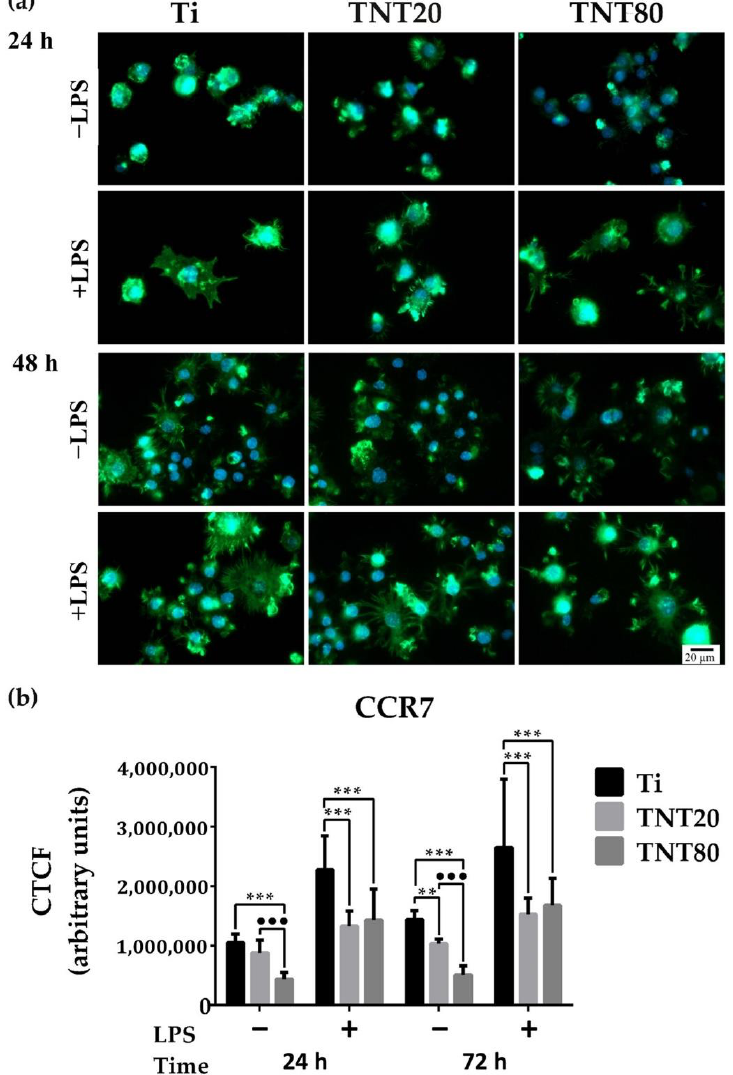
Figure 4. CCR7 expression in RAW 264.7 cells maintained in contact with the Ti, TNT20, and TNT80 surfaces for 24 h and 48 h, both under standard (−LPS) and pro-inflammatory (+LPS) culture condi- tions. ( a ) Immunofluorescence staining of CCR7 (green fluorescence: pro-inflammatory biomarker CCR7; blue fluorescence: cell nuclei). All images were captured at the same magnification (scale bare represents 20 µm). ( b ) Corrected total cellular florescence (CTCF) of individual cells quantified by using the Image J software. The macrophages grown on both nanotubular surfaces, especially TNT80, expressed significant reduction of the CCR7 fluorescence signals as compared to cells in contact with Ti substrate. Results are represented as means ± SD ( n = 30, ** p < 0.01, *** p < 0.001 vs. Ti, ••• p < 0.001 vs. TNT20).